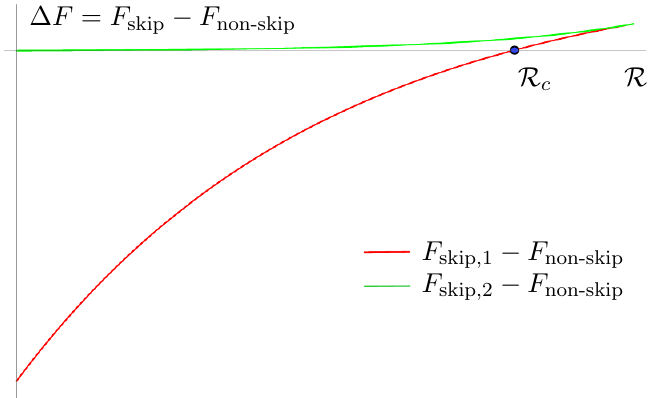
Figure 32. Free energy di(cid:11)erence between the skipping and the non-skipping solution. For a (cid:12)xed curvature, there are two skipping solutions for which the superpotential W ( ’ ) was denoted as W s; 1 ( ’ ) and W s; 2 ( ’ ) (they were denoted as red and green curves respectively in (cid:12)gures 25 and 26). In this (cid:12)gure, the red curve corresponds to the on-shell action di(cid:11)erence between the W s; 1 ( ’ ) solution and the non-skipping solution. The green curve corresponds to the on-shell action di(cid:11)erence between the W s; 2 ( ’ ) solution and the non-skipping solution W ns ( ’